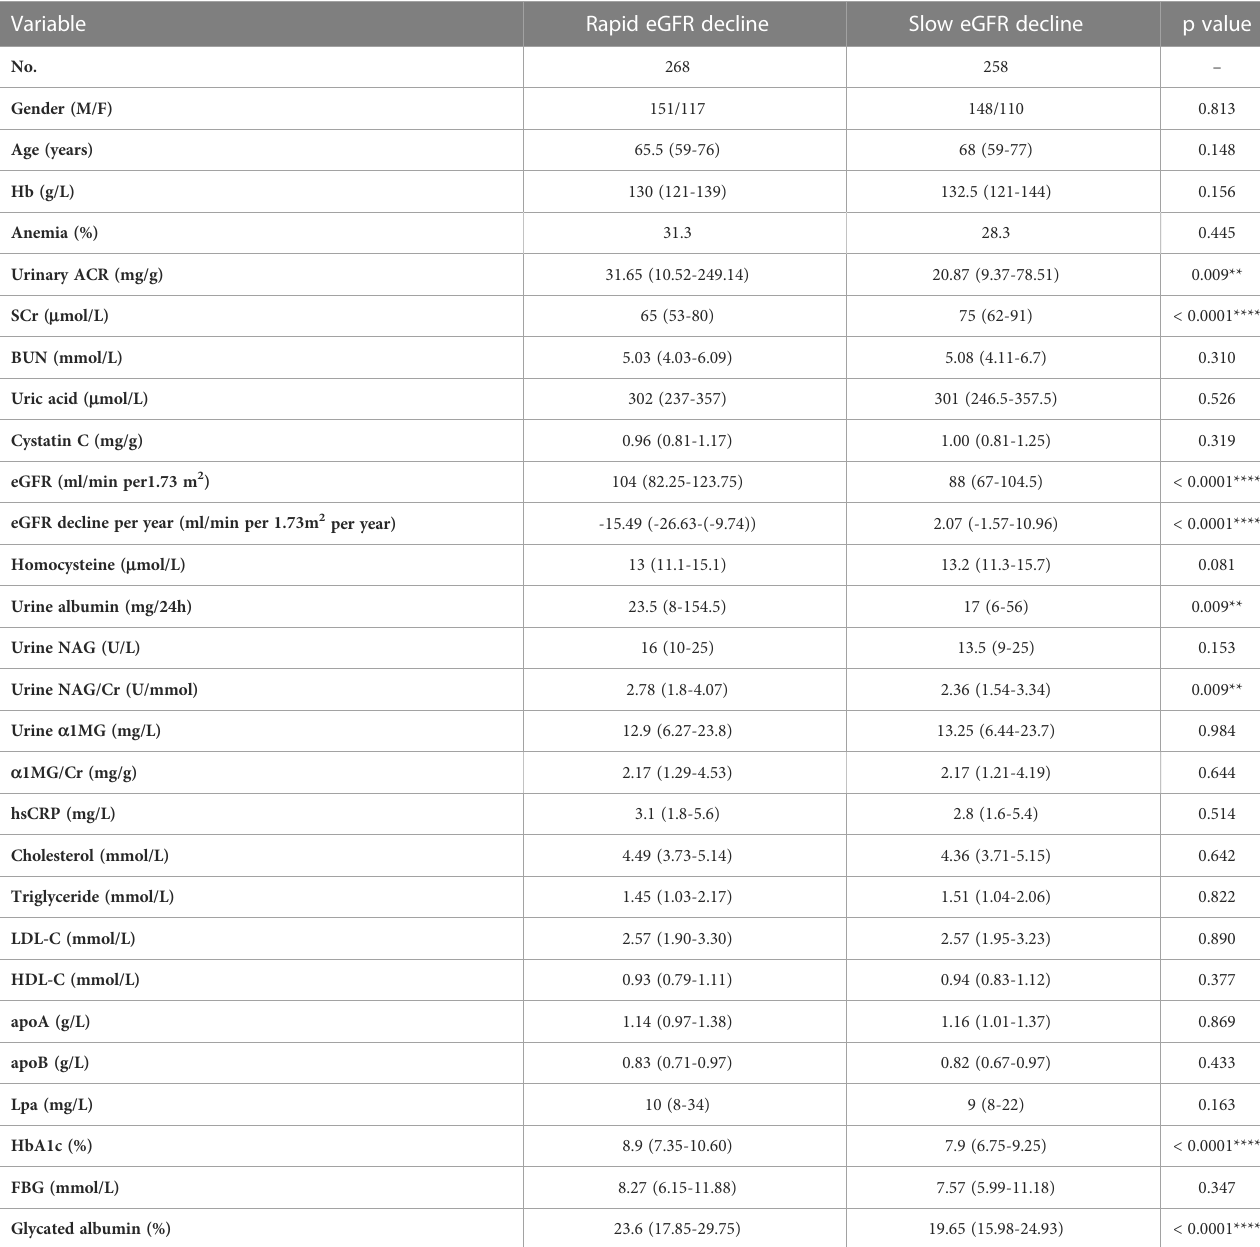
TABLE 4 Clinical characteristics of type 2 diabetic patients with rapid or slow eGFR decline during follow-up.